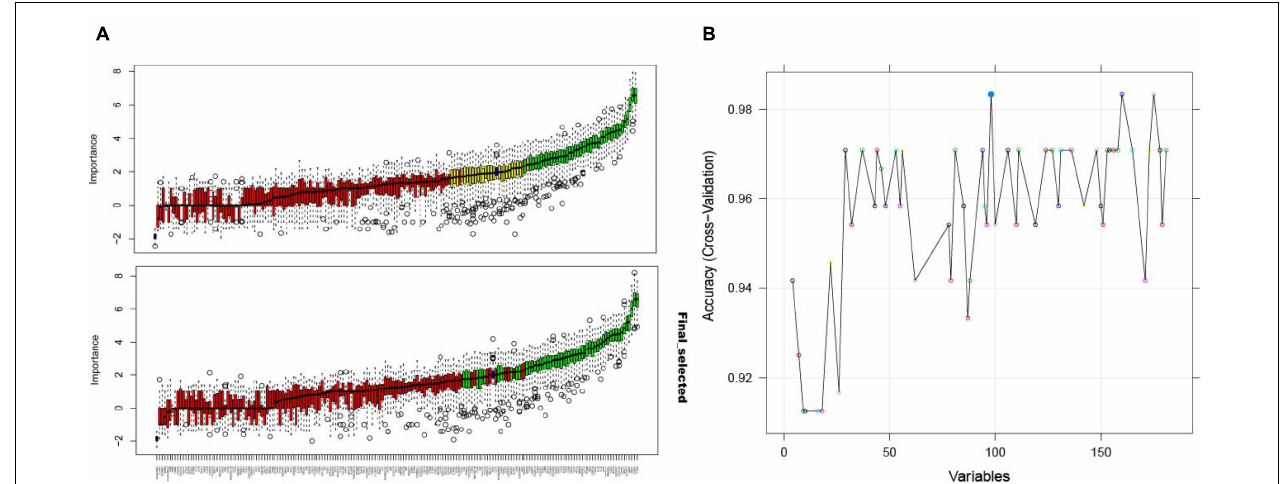
FIGURE 6 | The Boruta algorithm feature selection results of the GSE16561 dataset showing the results before and after the “TentativeRoughFix” function to remove undetermined features (A) ; accuracy score of the number of feature selections using the RFE algorithm for the GSE16561 dataset (B) .